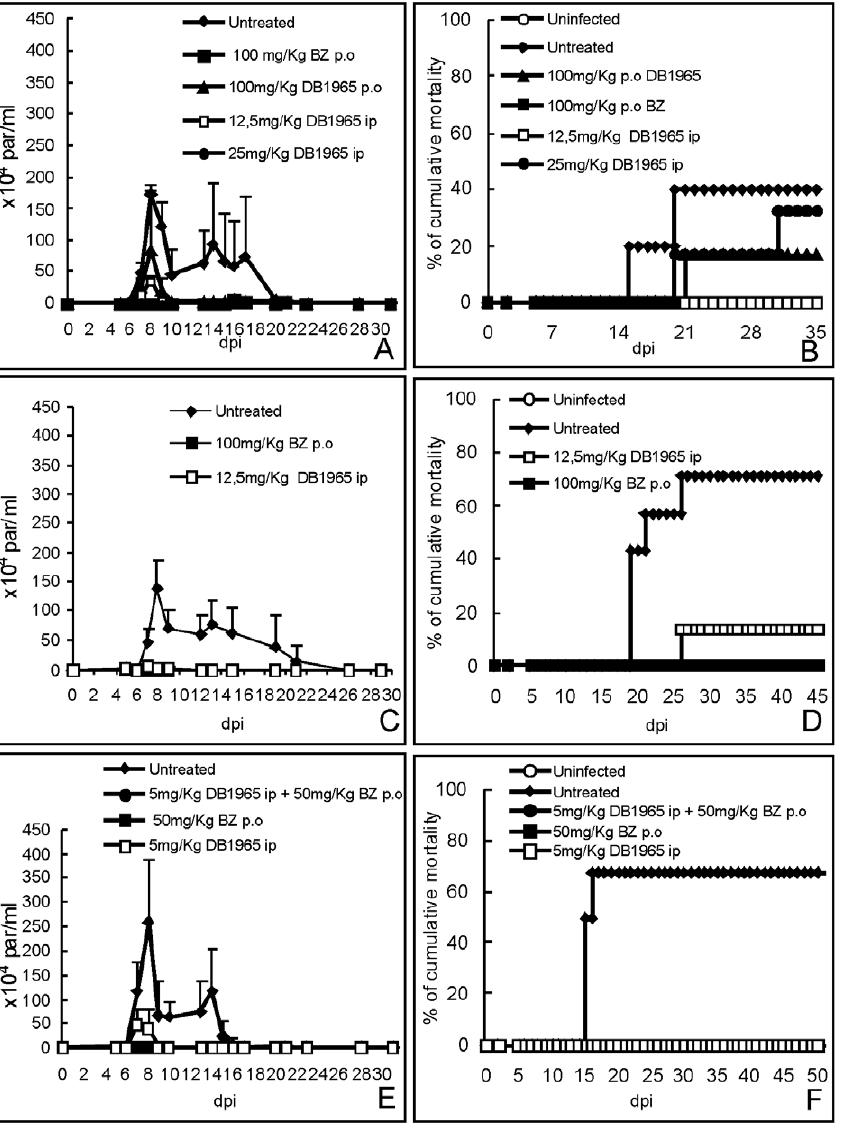
Figure 2. Treatment of T.cruzi -infected mice (10 4 Y strain/mice) with DB1965. The activity of 5 (E–F), 12.5 and 25 (A–D) mg/Kg/day of DB1965 (ip) and 100 mg/kg/day DB1965 via p.o (A–B) is presented. As reference drug, 50 and 100 mg/Kg/day benznidazole (by p.o) was also evaluated using similar therapeutic schemes at the 5–9 dpi (A–B), 5–14 dpi (C–D) and 5–24 dpi (E–F). Parasitaemia curves (A, C and E) and percentage of cumulative mortality (B, D and F) are shown. All assays were run at least two